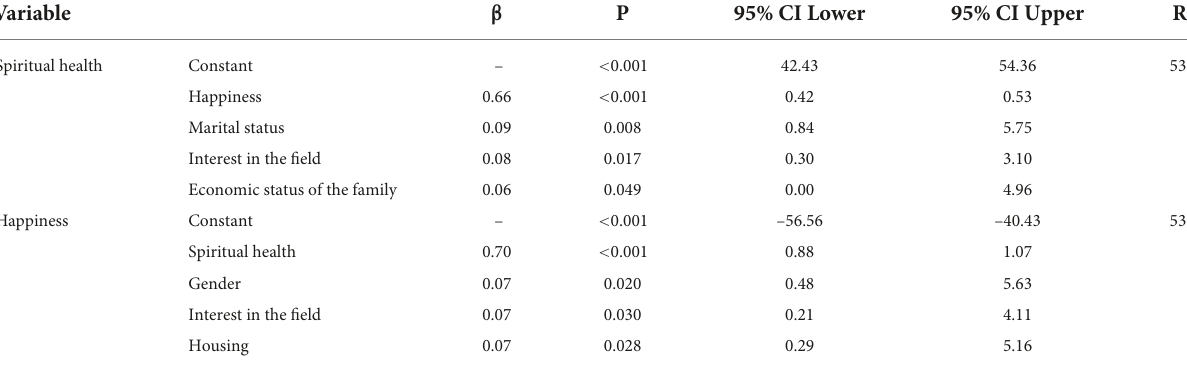
TABLE 4 Multiple regression analysis summary for underlying variables of spiritual health and happiness among students ( n = 409).